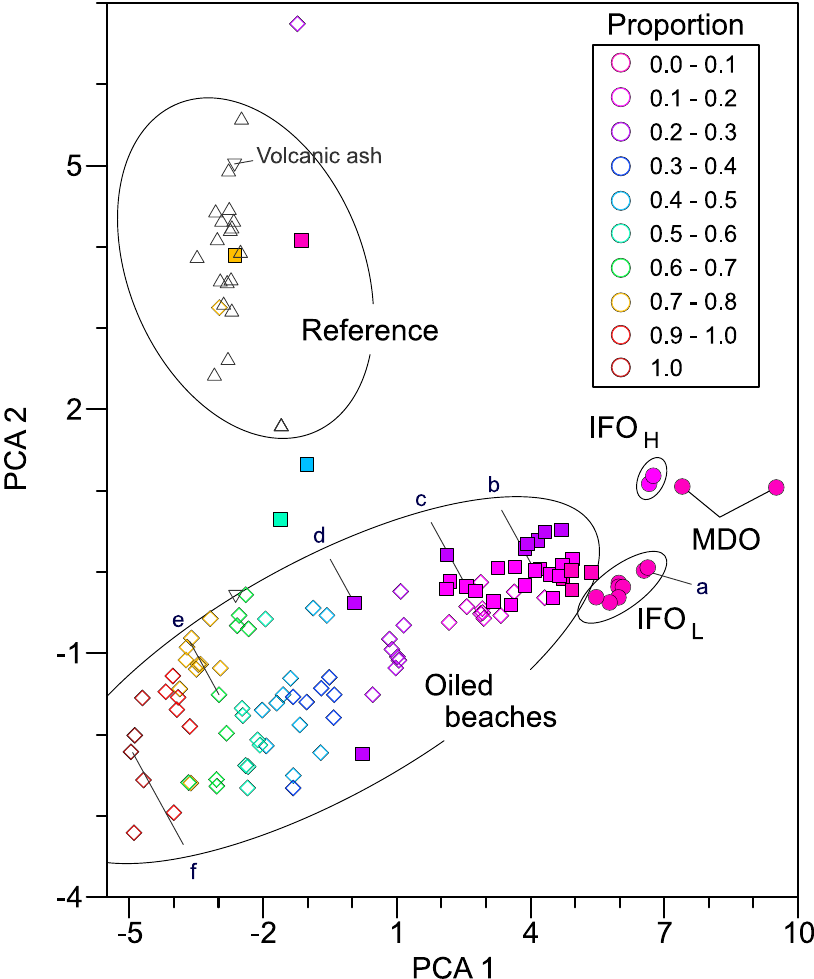
Fig 4. Discrimination of alkanes in reference and oiled samples by principal component analysis. Oiled samples are color coded by the proportion of heavy alkanes ( (cid:1) n -C27 alkanes). S . Ayu source oil is illustrated with solid circles. Source oil types were marine diesel oil (MDO), intermediate fuel oil light (IFO L ), and intermediate fuel oil heavy (IFO H ). Solid squares indicate oil from sediment in 2004 – 2005 and open diamonds indicate oil from 2008 sediment. Black triangles indicate non-oiled reference samples; open triangles represent 2008 data. Letters (a – f) indicate samples illustrated as examples in S3 Fig. The PCA 1 explained 40% of the variance and PCA 2 explained 14% of the